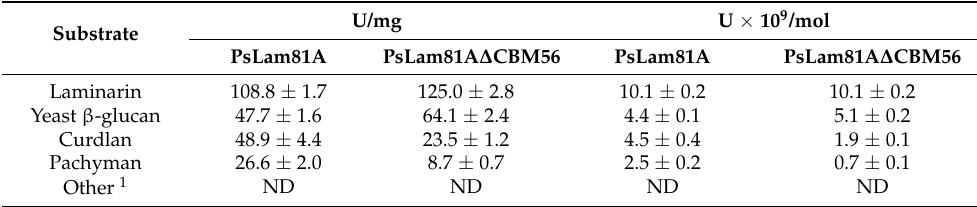
Table 2. Substrate specificity of PsLam81A and PsLam81A ∆